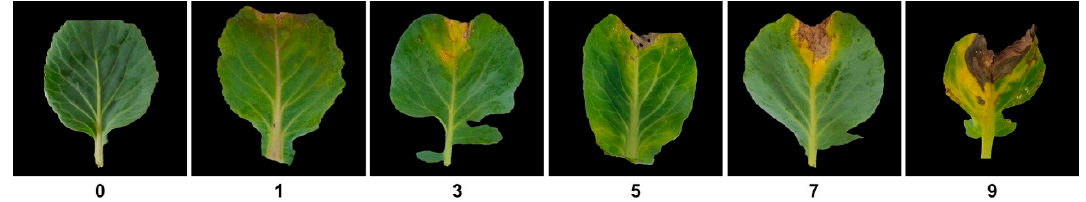
Figure 5. The disease rating criteria used in this study for black rot of cabbage. Scales are 0–9. 0, high resistant (HR); 1–3, resistant (R); 5–7, susceptible (S); 9, highly susceptible (HS).